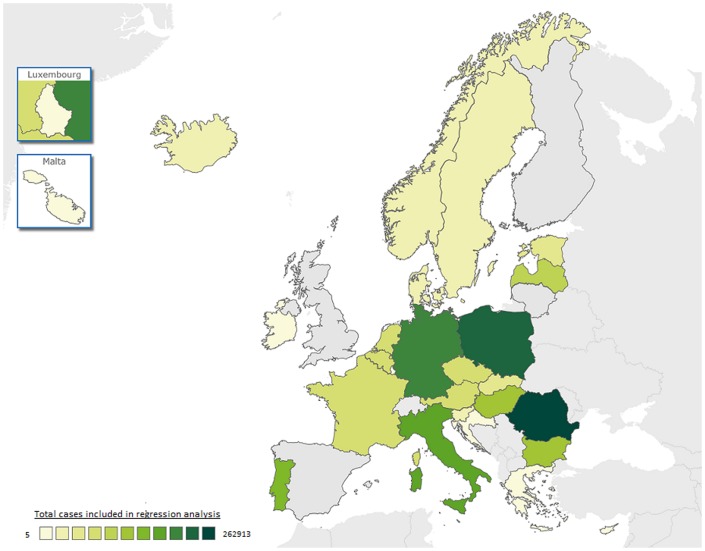
Distribution of TB cases in the 27 countries included in the multivariable analysis of determinants of site of TB, EU/EEA countries, 2003–2014.SOURCE OF GRAPHIC: ECDC Map Maker (EMMa), available at https://emma.ecdc.europa.euThe boundaries and names shown and the designations used on this map do not imply the expression of any opinion whatsoever on the part of the World Health Organization concerning the legal status of any country, territory, city or area or of its authorities, or concerning the delimitation of its frontiers or boundaries. Dotted lines on maps represent approximate border lines for which there may not yet be full agreement.